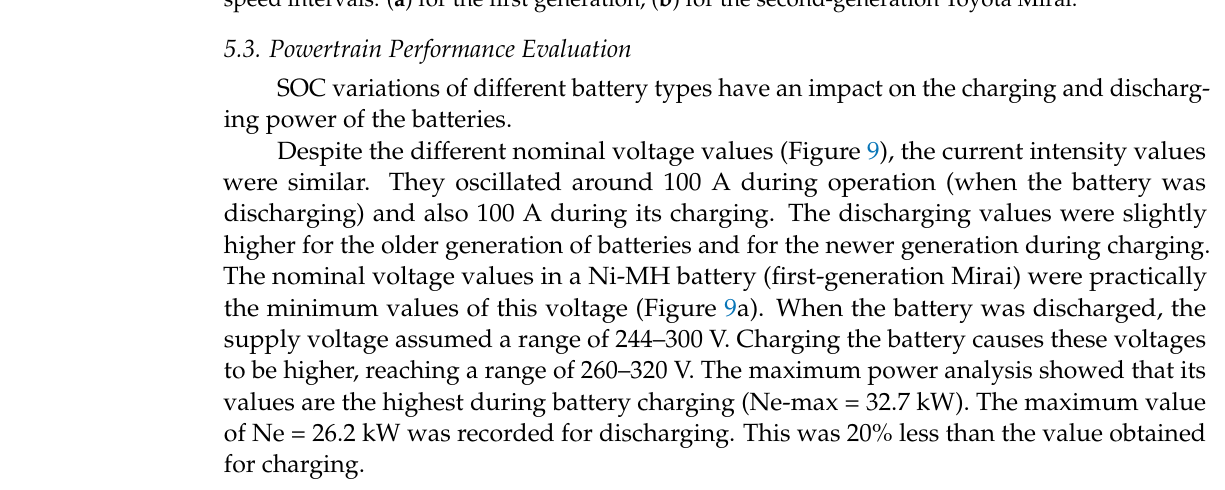
Figure 8. Interval analysis of SOC relative to the vehicle driving speed with the shares of the selected speed intervals: ( a ) for the first generation; ( b ) for the second-generation Toyota Mirai.